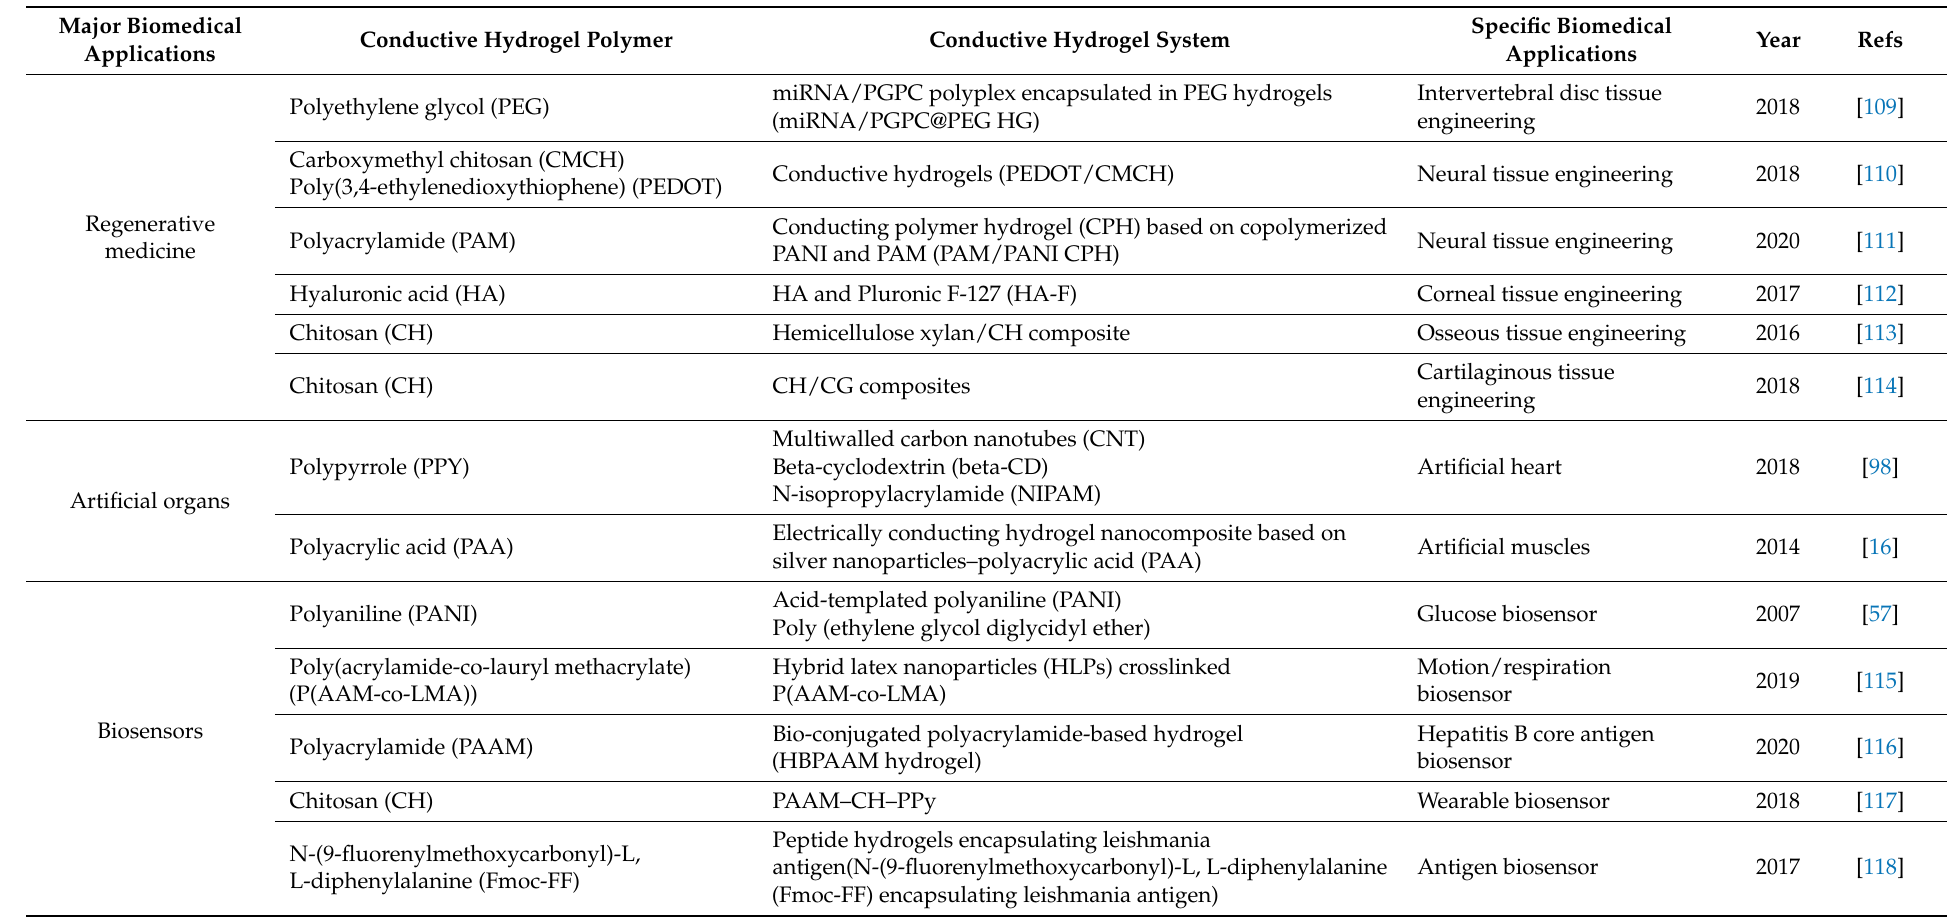
Table 3. CHs employed for different biomedical